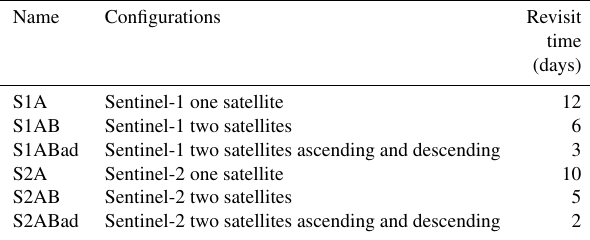
Table 1. Configurations used in the study for different revisit times based on the combinations of